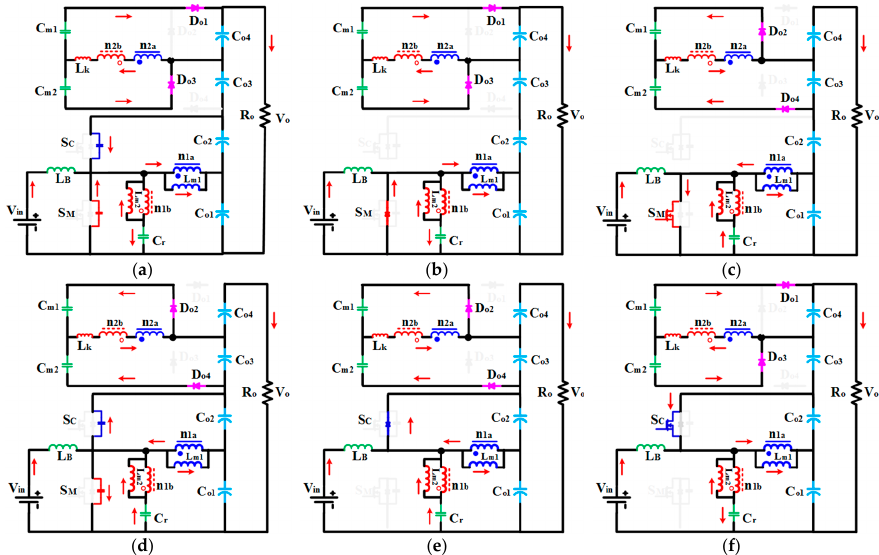
Figure 3. Operation modes: ( a ) Mode 1; ( b ) Mode 2; ( c ) Mode 3; ( d ) Mode 4; ( e ) Mode5; and ( f ) Mode 6. Inventions 2018 , 3 , x